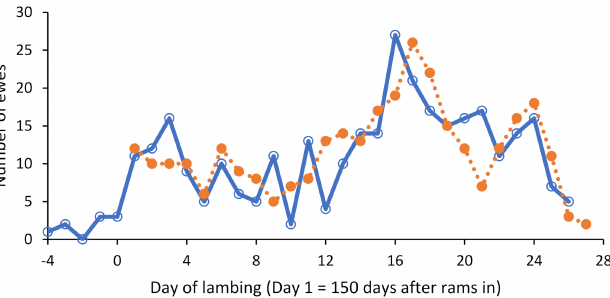
Figure 2. Daily frequency of ewe actual day of lambing (solid line) compared to predicted day of lambing (dotted line) based on the maximum daily interactions ratio ( n = 317).